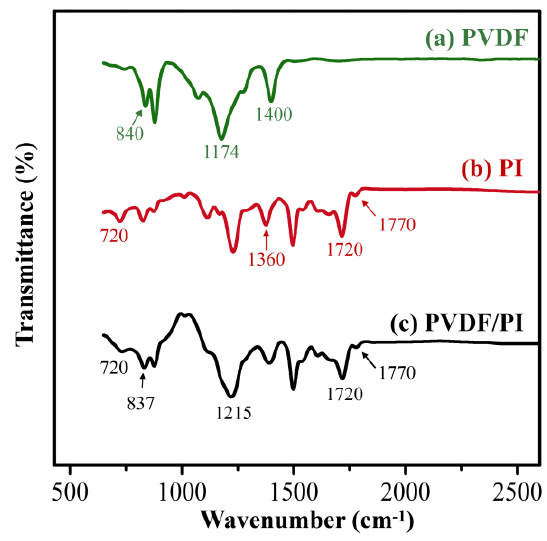
Figure 3. The FTIR spectra of PVDF ( a ), PI ( b ), and PVDF/PI ( c ) nanofibers.